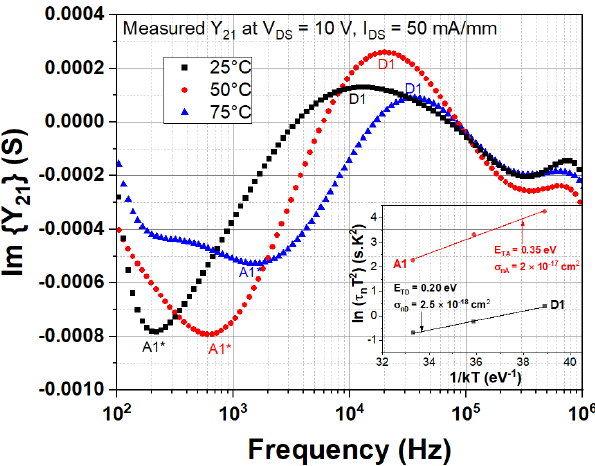
Figure 16. The measured LF Y 21 spectra acquired at V DS = 10 V, I DS = 50 mA/mm for different temperatures (25 to 75 °C) reveal a buffer trap A1* at E C –0.35 eV and surface donor at E C –0.2 eV.